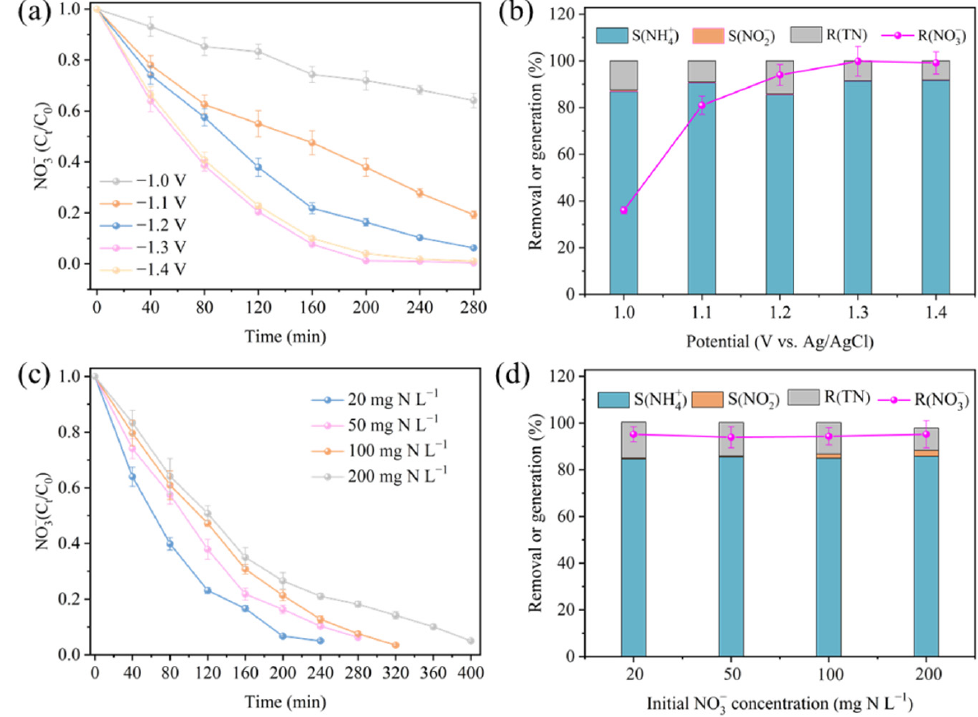
Figure 5. Effect of cathodic potential on NO 3 − reduction ( a , b ). Electrolysis conditions: Initial NO 3 − concentration = 50 mg N L − 1 , Solution volume = 80 mL, pH = 7.0, Stirring rate = 600 rpm, Electrolysis time = 5 h; Effect of initial NO 3 − concentration on NO 3 − reduction ( c ) and removal or generation efficiency ( d ); Electrolysis conditions: Cathodic potential = − 1.2 V (vs. Ag/AgCl), Solution volume = 80 mL, pH = 7.0, Stirring rate = 600 rpm, Electrolysis time = 5 h.